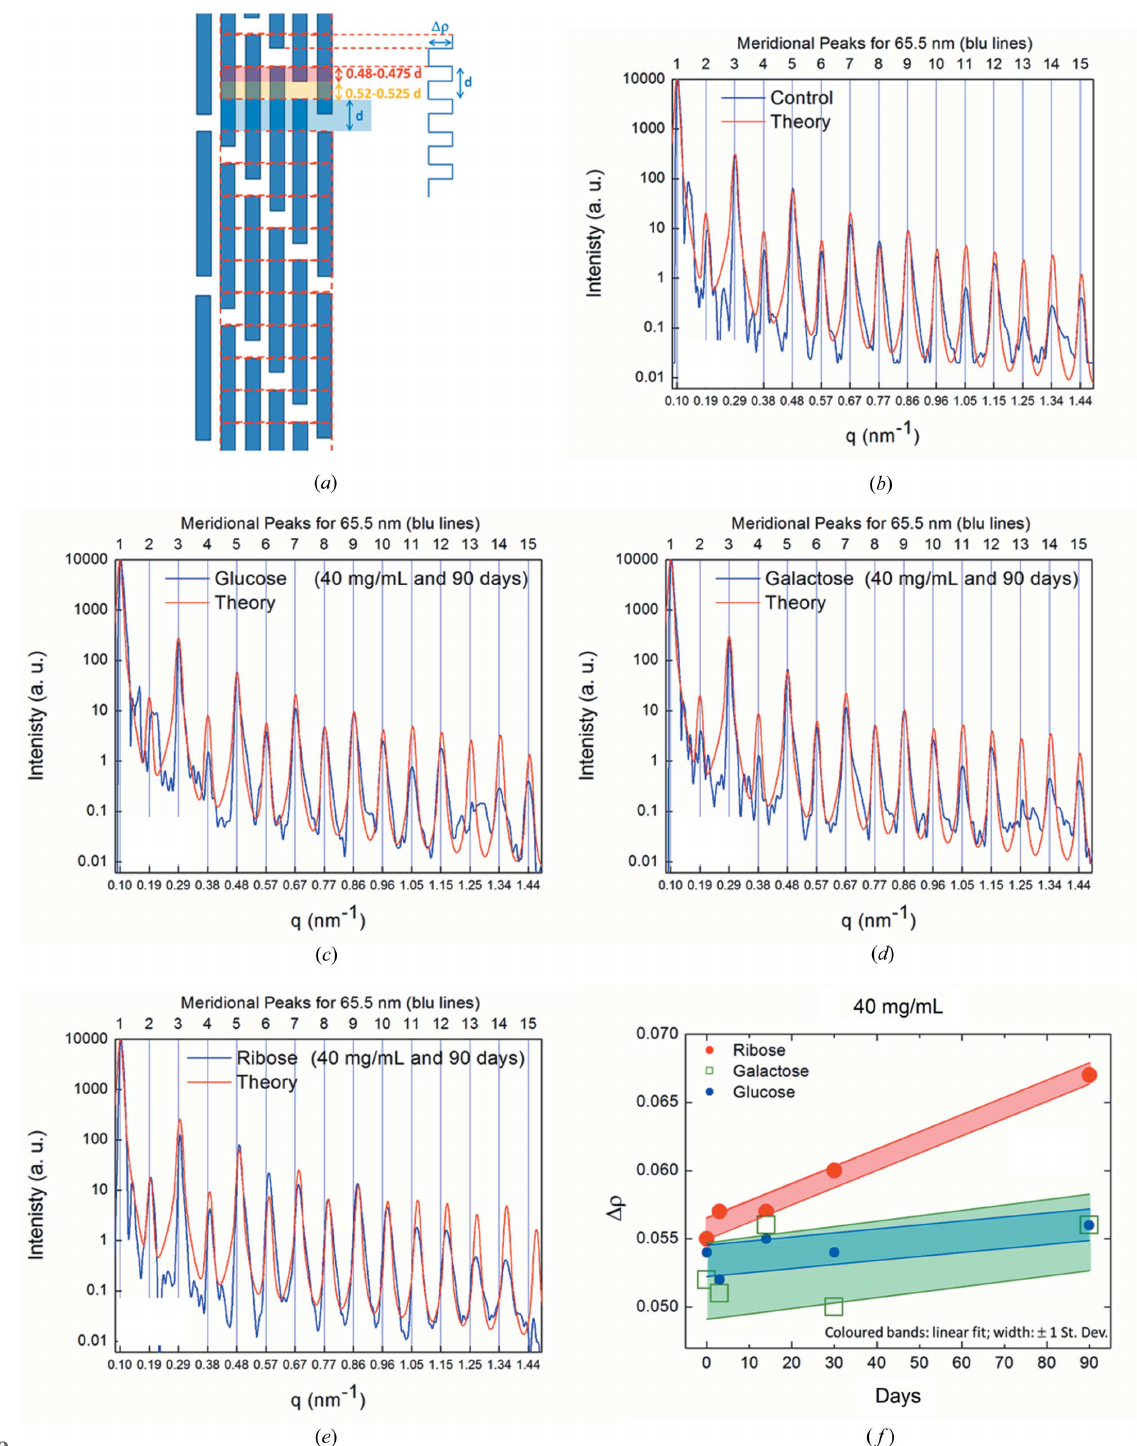
Figure 2 ( a ) A model of the microfibrillar arrangement and thereby electron-density distribution along the collagen fibers used to describe the SAXS data. These data are shown in experimental SAXS profiles (blue curves), extracted by averaging all profiles for ( b ) the control sample, ( c ) glucose, ( d ) galactose and ( e ) ribose (data for sugars refer to 40 mg ml (cid:2) 1 and 90 days), and compared with the theory (red curves). ( f ) Electron-density difference (cid:2) (cid:5) in the overlap region of length d , normalized with respect to the (cid:5) Ave value, as a function of sugar incubation time. The number of periods that interfere, determined by the comparison with the theory, is N = 10, for all the experimental ( R 2 ) 1/2 is due to only one of the fitting parameters, e.g. (cid:2) (cid:5) , we function – with respect to the real electron density of the still have a systematic error on its determination, due to the collagen structure, of the order of 10%, since 1 (cid:2) ( R 2 ) 1/2 approximation of the theoretical model – i.e. the step-like ranges from 0.09 to 0.13. Fig. 2( f ) shows a variability in (cid:2) (cid:5) as